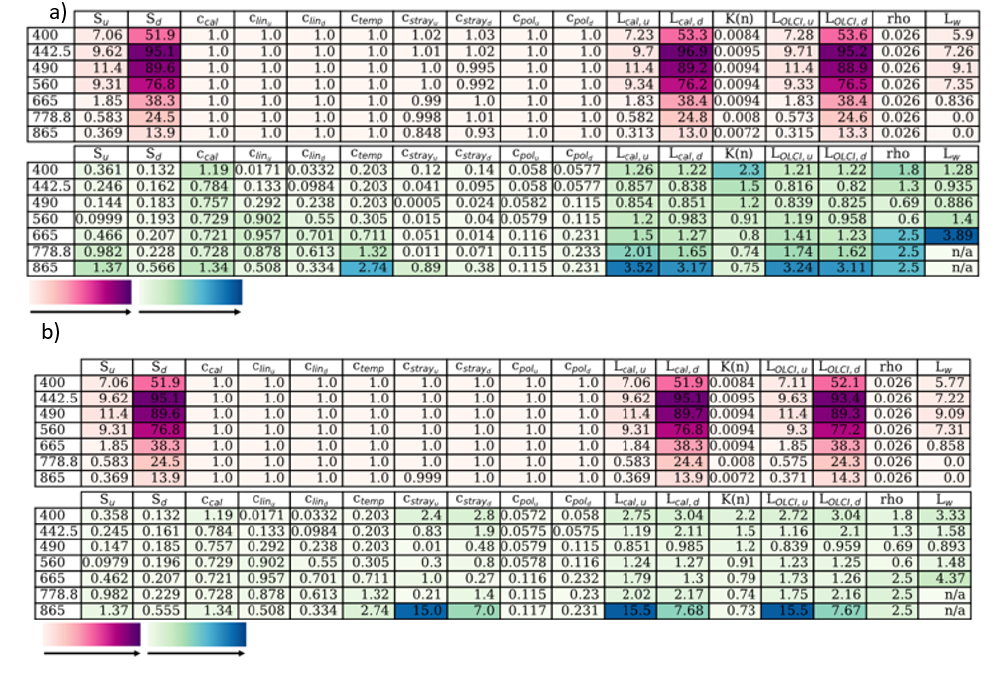
Figure 12. Water-leaving radiance MCM outputs. ( a ) Ideal case results. The mean (top panel) and standard uncertainty as a percentage of the mean (second panel) of each variable. This is shown for all OLCI bands of interest and relates to cast 1. The colour code intensity indicates the magnitude, ( b ) Non-Ideal case results. The mean (third panel) and standard uncertainty as a percentage of the mean (lower panel) of each